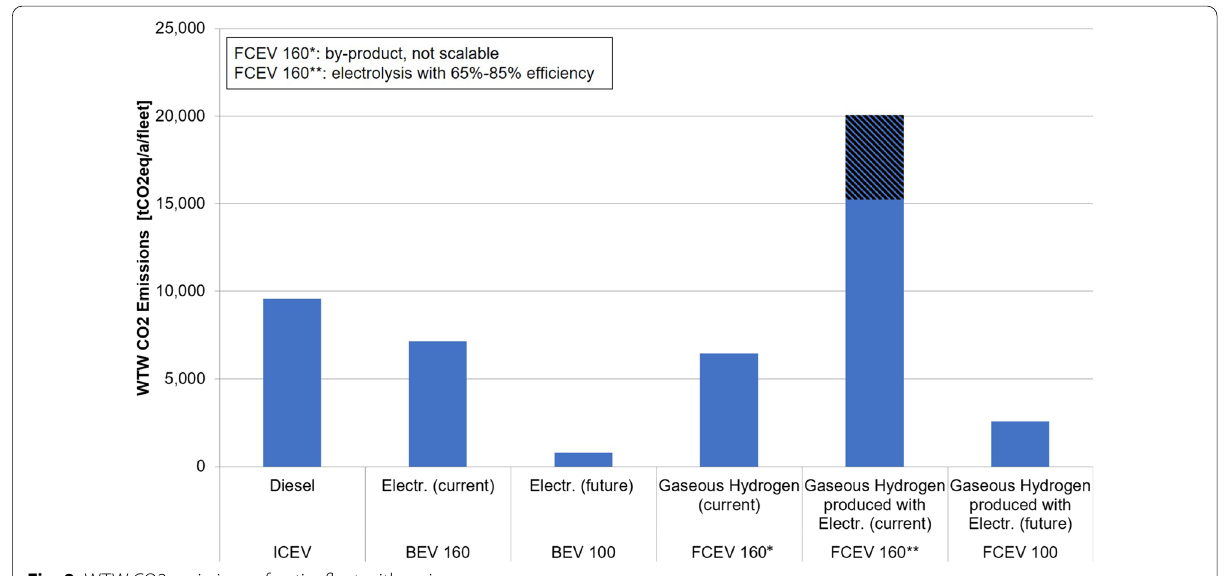
Fig. 8 WTW CO2 emissions of entire fleet with various energy sources